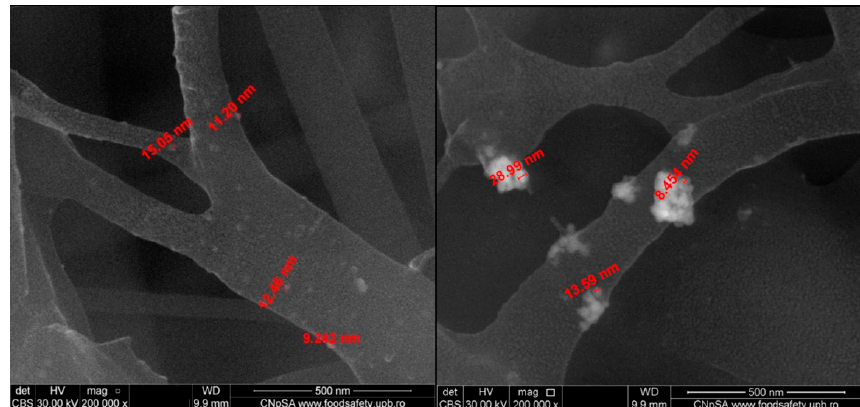
Figure 5. SEM images recorded in backscattering for PET_5_NanoAg.